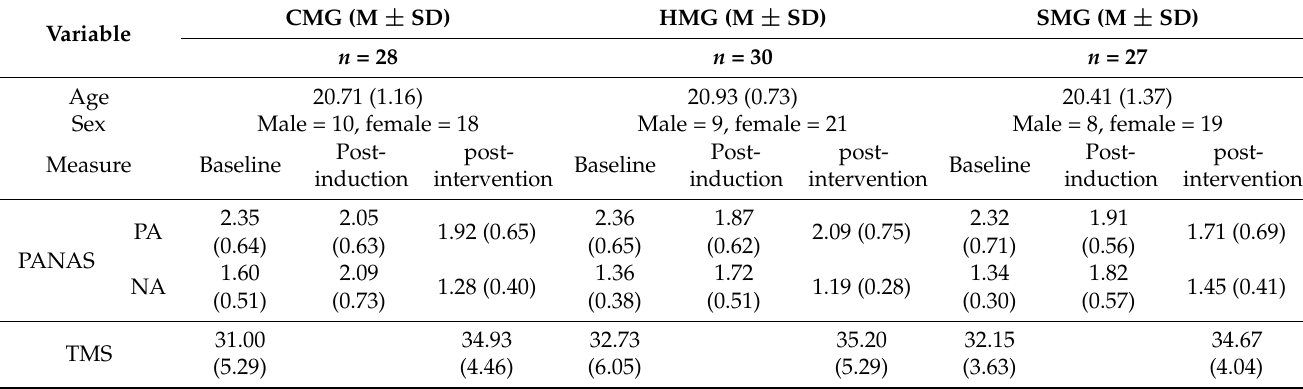
Table 1. Participants’ demographic information and self-report results.